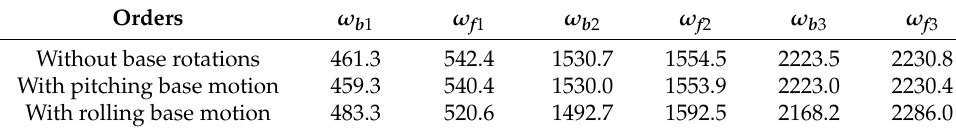
Table 5. Natural frequencies of the counter-rotating dual-rotor system (rad/s).